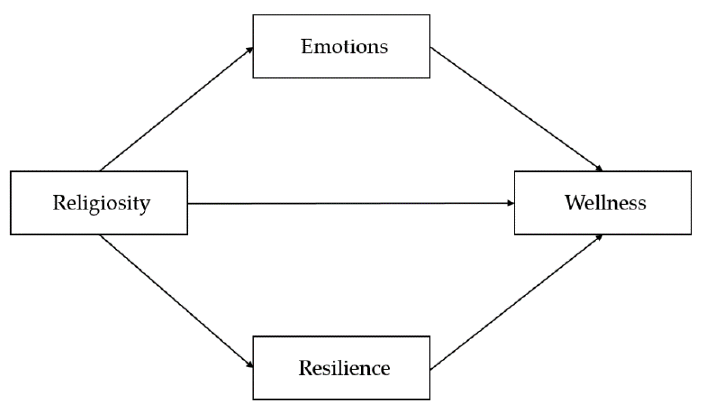
Figure 1. Conceptual framework of the study.